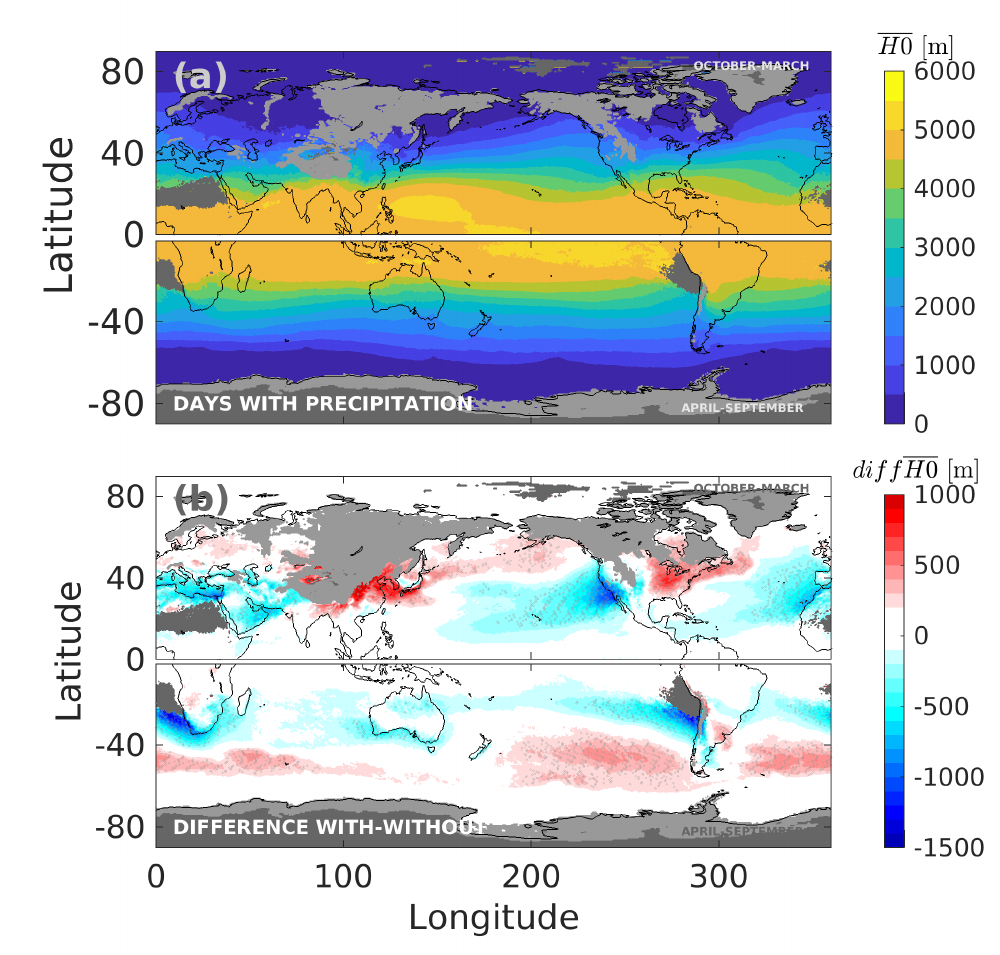
Figure 1. ( a ) Global distribution of mean H 0 (m above sea level (ASL)) calculated at any given grid box for days with precipitation (>5 mm/day in the grid box) during winter months (October–March for the Northern Hemisphere and April–September for the Southern Hemisphere). Data from the Climate Forecast System Reanalysis (CFSR) (see details in Section 3). ( b ) Difference of the mean H 0 between days with and without precipitation. Light gray areas represent those regions where mean H 0 intersects the topography. Dark gray areas indicate arid regions where the low number of rainy days precludes a robust calculation of H 0 under wet